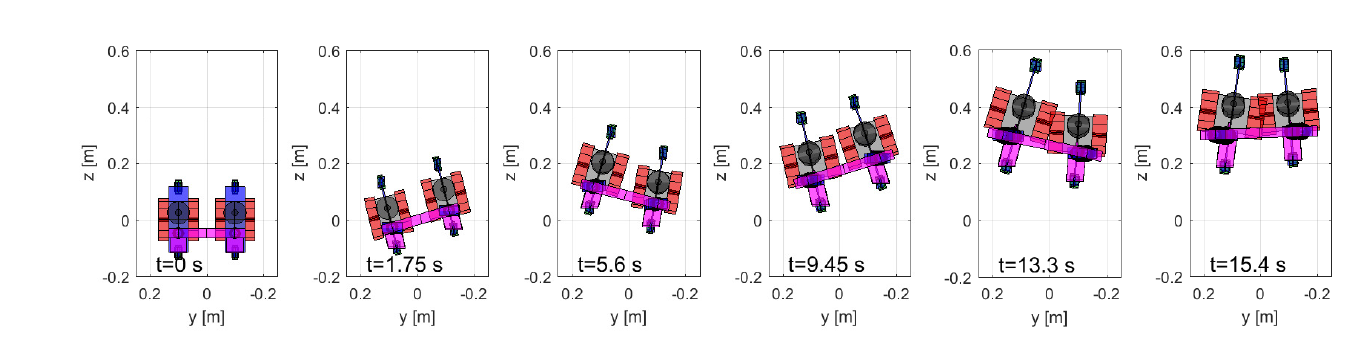
Figure 6. Simulation of Rollo implementing human-like